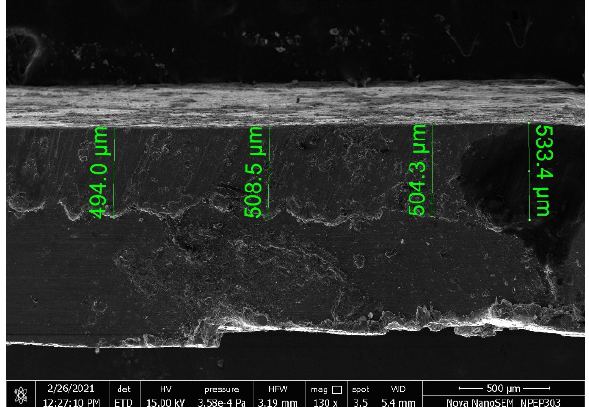
Figure 10: Uniformly distributed oxide layer at the cross-section of Al 6061